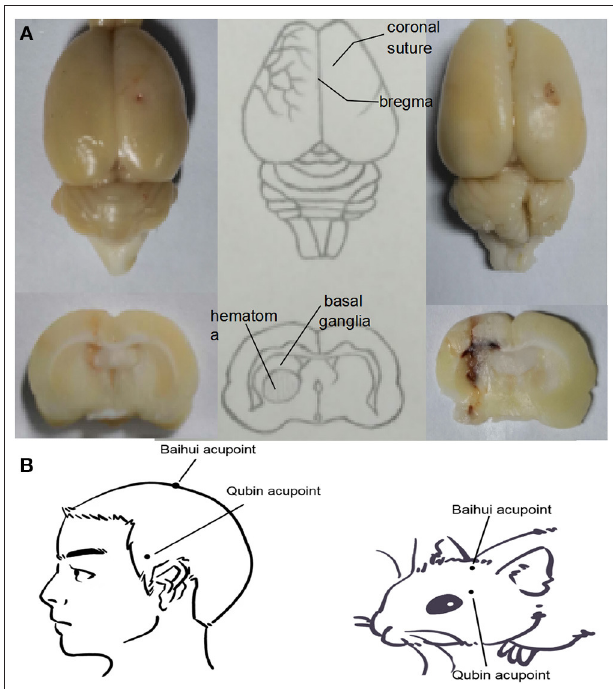
FIGURE 1 | (A) Location of the ICH hematoma. Schematic showing the position of the blood transfusion into the caudate putamen. (B) Location of Baihui acupoint and Qubin acupoint in human and rats. Baihui acupoint is located at the midpoint of the line between the double ear tips on the parietal bone, and Qubin acupoint is located at 2/3 of the line from the orbital margin to the external ear